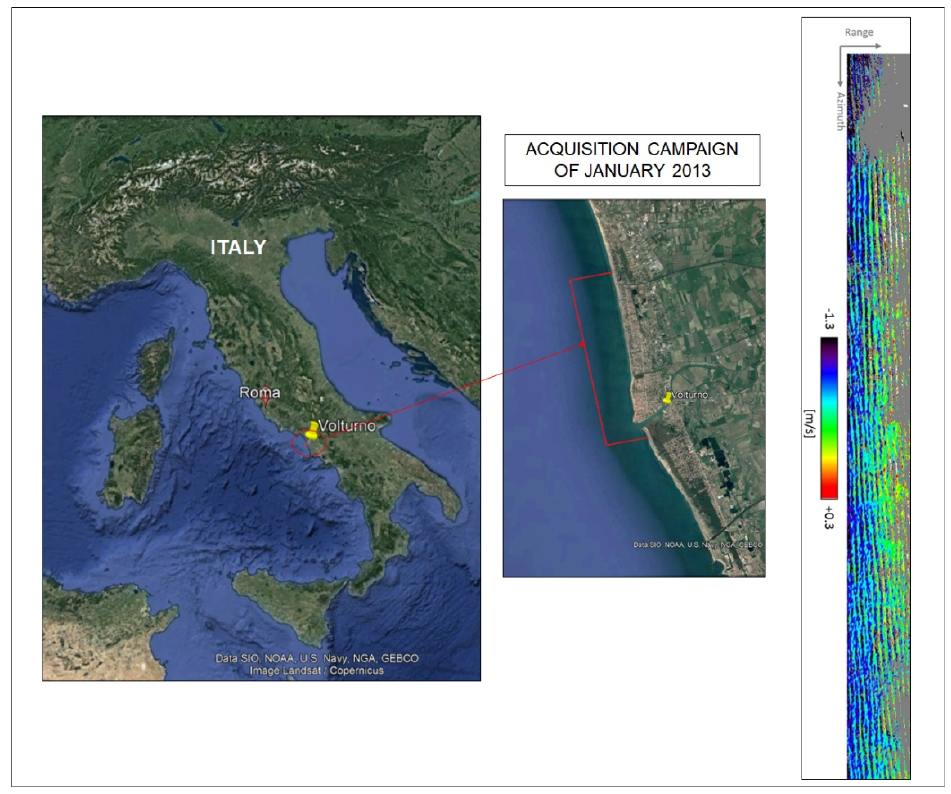
Figure 3. Test site presented in [281], situated along the coast of southern Italy. The middle panel displays a zoomed-in view of the area of interest. The right panel shows the sea surface velocity map obtained from the ATI technique [281].